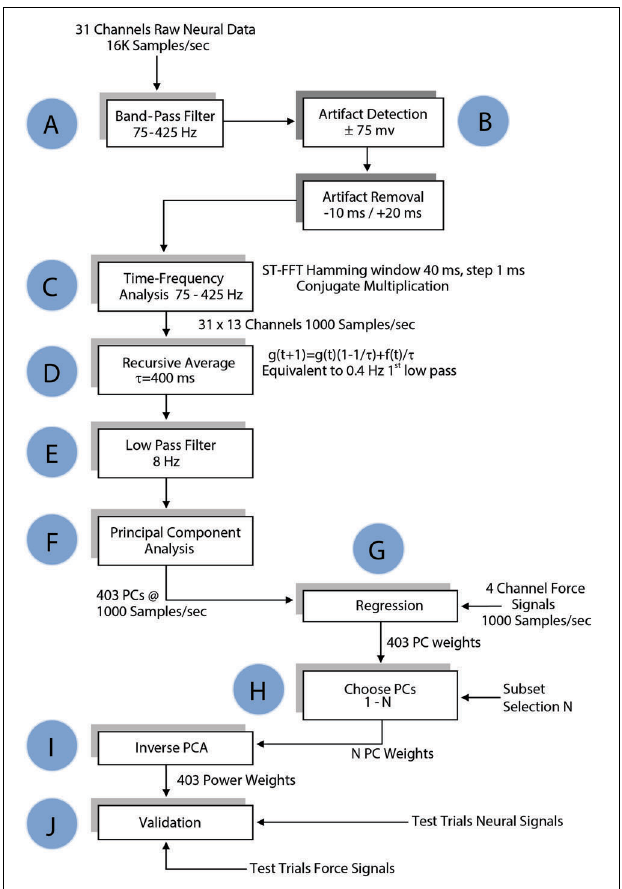
FIGURE 4 | Flow chart of data processing algorithm for regressing the forelimb force in a single axis. The same algorithm was applied to all three dimensions of the force in Cartesian coordinates and to the absolute value of the force. See Methods for details.